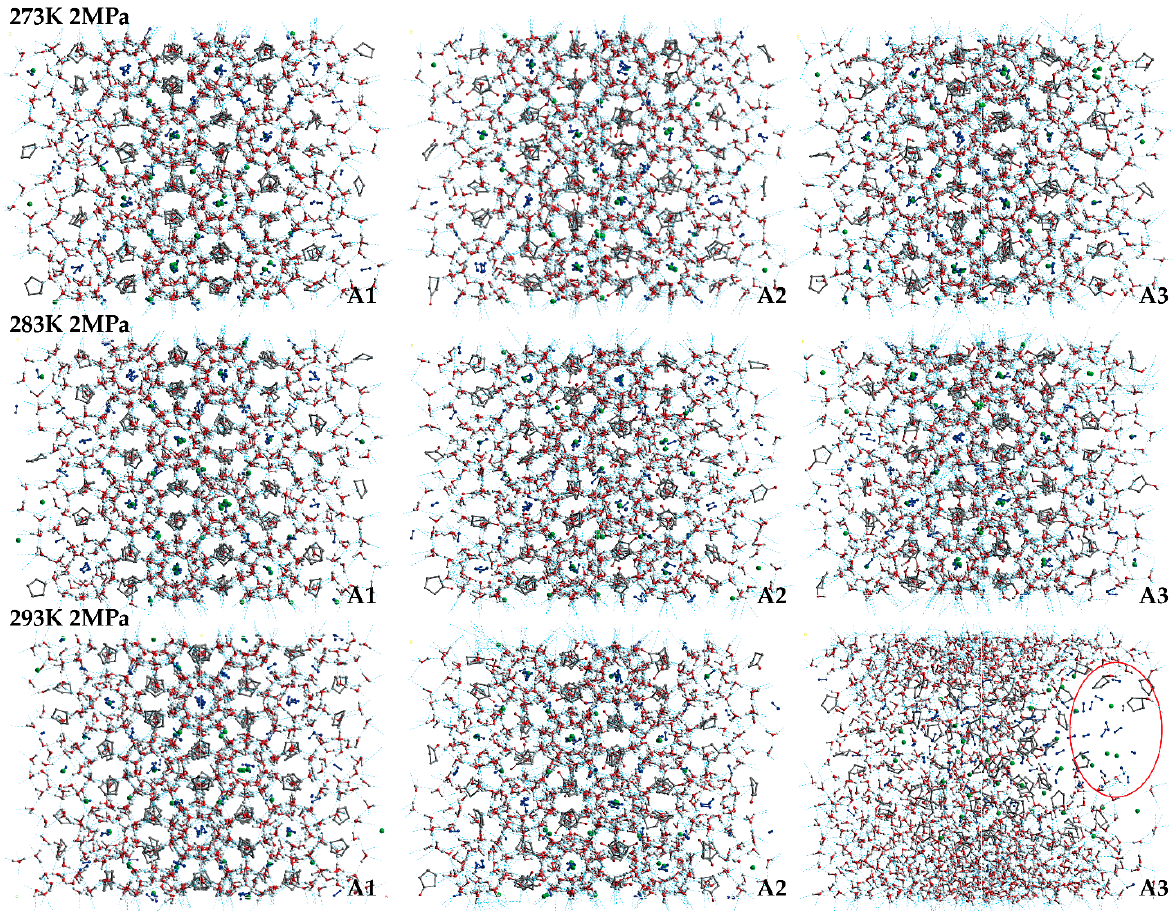
Figure 2. Final snapshots of molecular dynamic runs to simulate A1 , A2, and A3 model structure after 500 ps at P = 2 MPa and T = 273 K, 283 K, and 293 K. The red circle represents the bubble formed by the accumulation of gas molecules in the system.